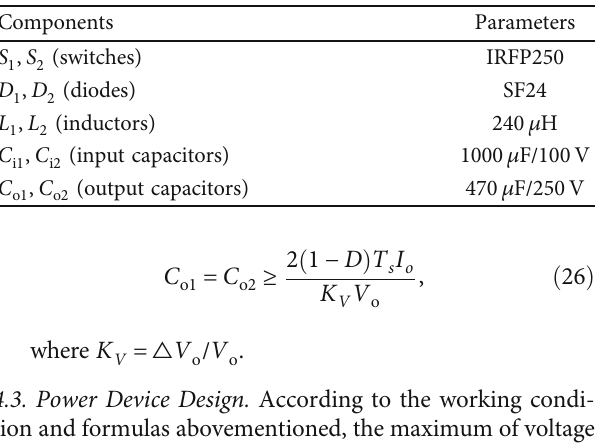
Table 2: Experimental